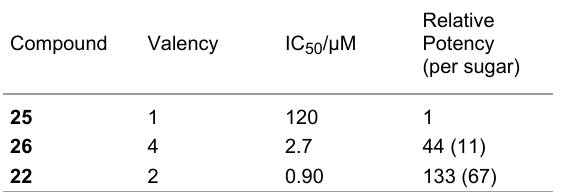
Table 1: Inhibitory potency of mono, di- and tetravalent galactosides on LecA binding a .